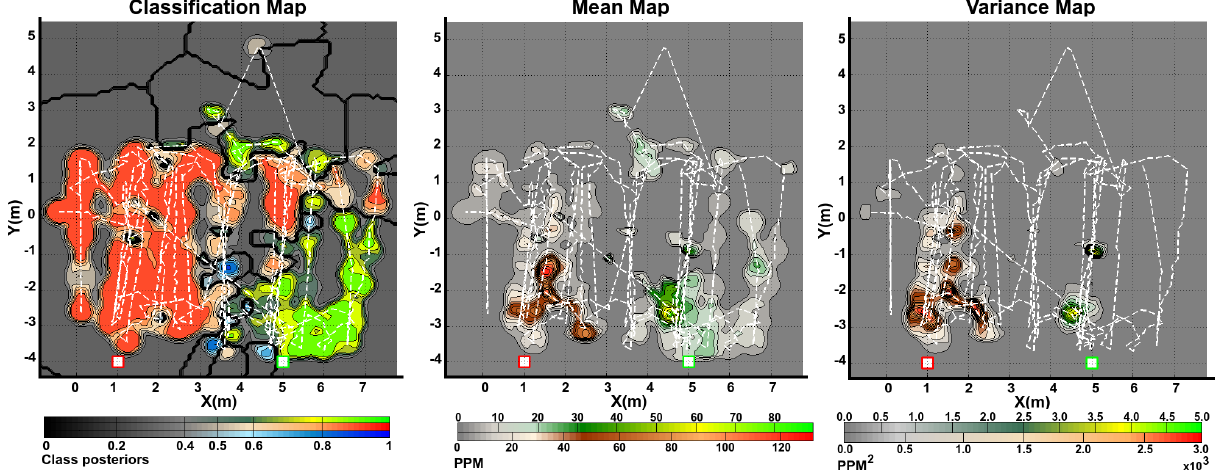
Figure 7. Generated gas distribution models in the outdoor experiment. In all the maps, green shades corresponds to ethanol and red shades correspond to acetone. The blue shades in the classification maps denote the likelihood of finding clean air at a given position in the explored area. The dashed lines denote the robot’s path and the actual source locations are indicated by squared